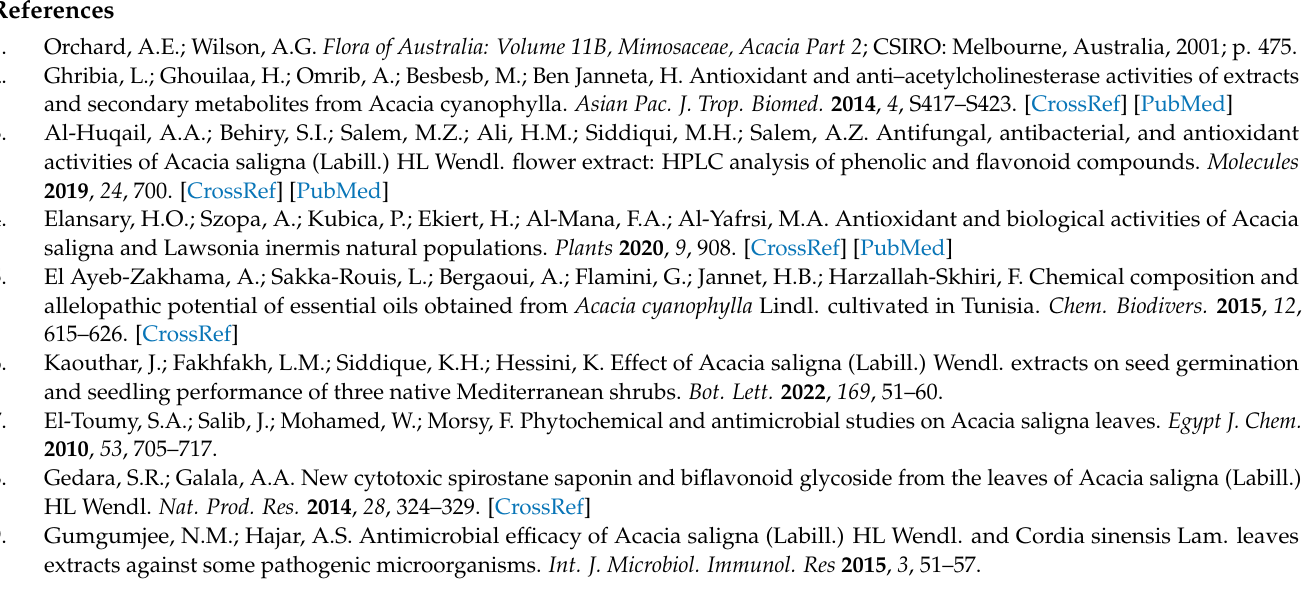
inhibition (%) of BK-MeOH; Table S8 & Figure S5: Percentage of α -glucosidase inhibition (%) of acarbose; Figure S6: Schematic fractionation of FL-MeOH extract of A. saligna ; Table S9: NMR data of FL-MeOH-A1 compared to reported naringenin 1 ; Table S10: NMR data of FL-MeOH-B1b compared to reported isosalipurposide 3 ; Table S11: NMR data FL-MeOH-B2b compared to reported quercitrin 4; Table S12: NMR data of FL-MeOH-B3b compared to reported D-pinitol 5a; Figure S7: Schematic of fractionation of LF-MeOH extract of A. saligna ; Table S13: NMR data of LF-MeOH-A1 compared to reported (-)-epicatechin 6 ; Table S14: NMR data of LF-MeOH-A3 compared to 2,4-di-t-buylphenol 7 ; Table S15: NMR data of LF-MeOH-C2b compared to reported myricitrin 8 ; Figure S8: Schematic fractionation of BK-MeOH extract of A. saligna ; Table S16: NMR data of BK-MeOH-C compared to reported sucrose; Table S17: The DPPH scavenging properties of the isolated compounds; Table S18: The ABTS • + scavenging properties of the isolated compounds; Table S19: GC analysis of BK-MeOH; Figure S9: Inhibitory activity of isolated compounds against the α -glucosidase; Table S20: Inhibitory activity of the isolated compounds against the α -glucosidase